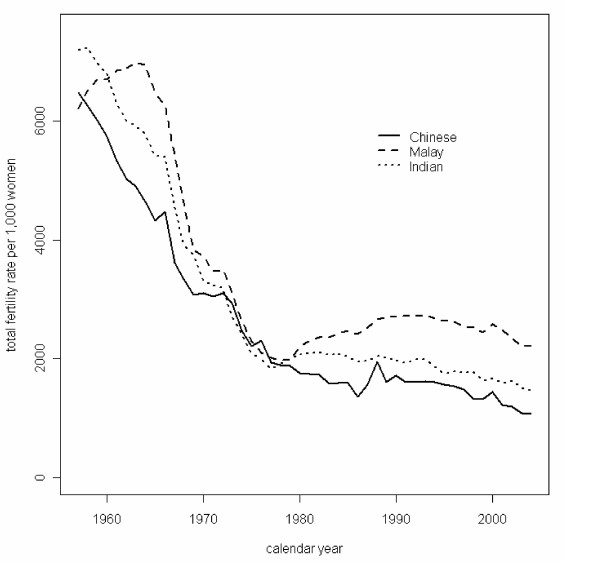
Total fertility rates for Singaporean women aged 15 – 44 from 1968 – 2002, stratified by ethnicity. Source: Reports on Registration of Births and Deaths (1968 – 2002). (Note: Only number of live births in each year is included and female population denominators used are based on interpolation of census data in 1970, 1980, 1990 and 2000).